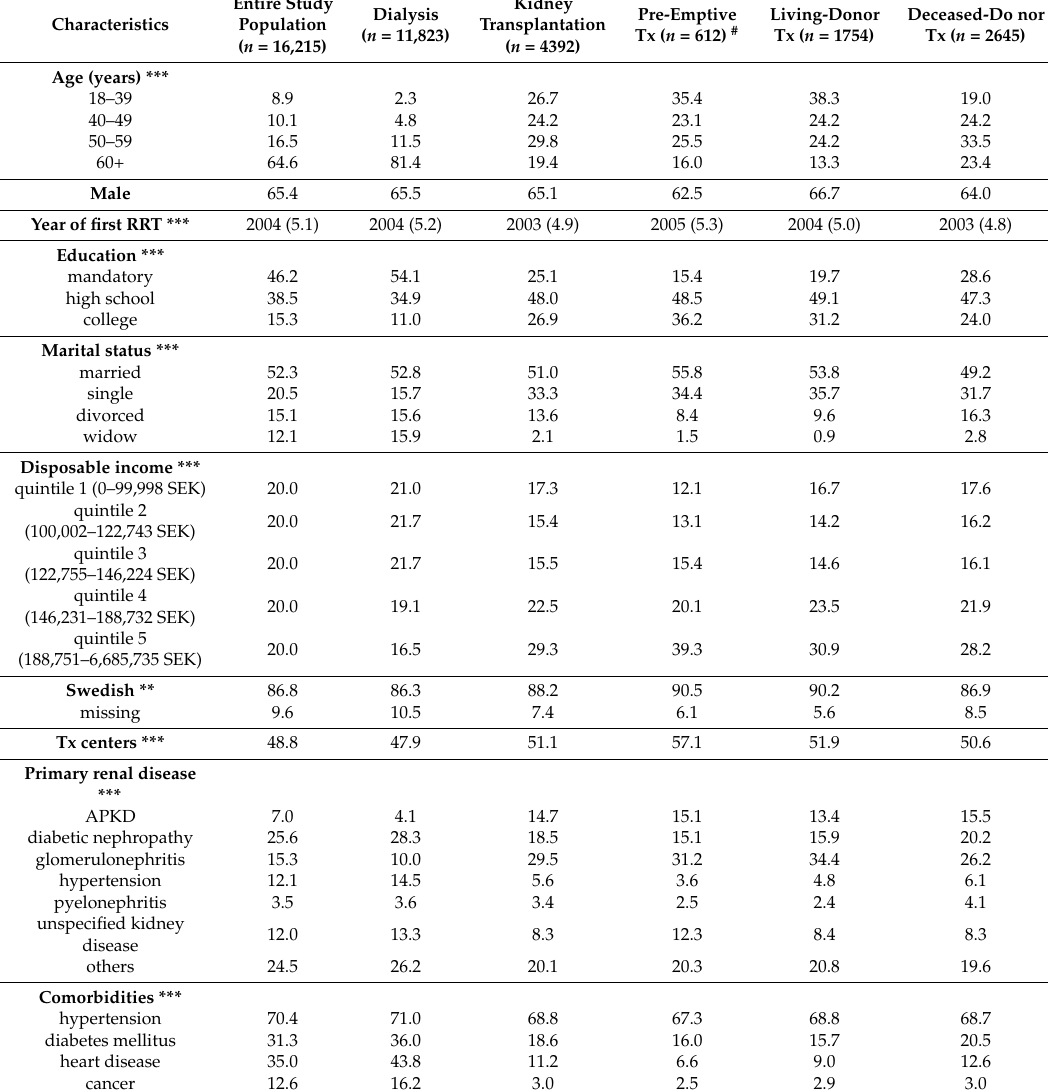
Table 1. Baseline patient characteristics by treatment modality at the start of